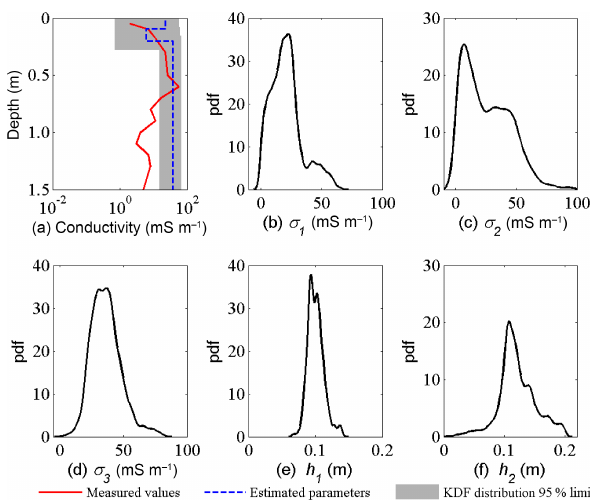
Figure 8. Summary of the MCMC simulation for three-layer earth model by considering CMD Mini-Explorer measurement over a saline soil. (a) True (red line) and estimated parameter (blue dashed line) for the vertical electrical conductivity profile, and the gray background with the 95% confidence interval of kernel distribution estimation (KDE). (b–f) The KDE of the marginalized posterior dis- tributions for the three layer conductivities ( σ 1 , σ 2 , and σ 3 ) and two layer thicknesses ( h 1 and h 2 ).